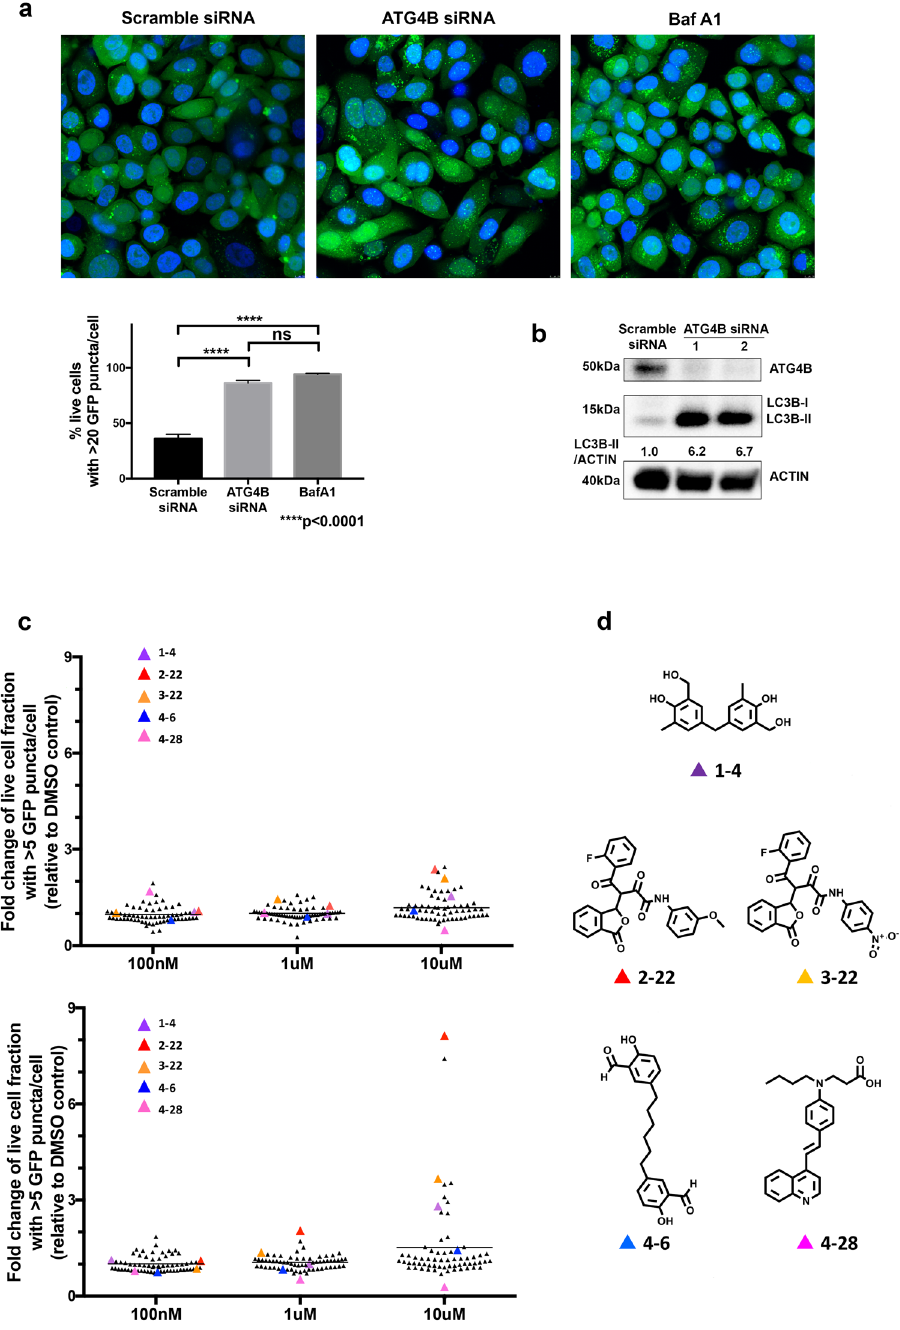
Figure 2. Screening of candidate ATG4B inhibitors. ( a ) Representative images of SKBR3-hrGFP-LC3B cells treated with control scramble-siRNA, ATG4B-siRNA, or bafilomycin A1 with quantitation of GFP-LC3B puncta shown in the bar graph below. Five randomly selected fields for each condition were analyzed in 2 independent experiments; error bars, SEM. ( b ) Representative western blot (n = 3) shows elevated LC3B-II levels in SKBR3 cells treated with ATG4B-siRNA compared to the control scramble-siRNA. Full-length blots are presented in Fig. S1. ( c ) Effect of small molecule compounds on the fraction of live cells with greater than five GFP-LC3B puncta in SKBR3 hrGFP-LC3 cells. Compounds were tested at three concentrations (100 nM, 1 μ M and 10 μ M) and two time-points, 6 h (top graph) and 24 h (bottom graph). The average values (normalized to DMSO vehicle control) from 3 independent experiments are shown. Colored triangles indicate 5 compounds that showed a statistically significant difference (p < 0.05) compared to vehicle control at one or more concentrations and timepoints and also inhibited ATG4B enzyme activity in a dose dependent manner (Table S1). Of these 5 compounds, only 2–22 and 3–22 showed a statistically significant difference at the 6 h time-point, while all 5 compounds showed a significant difference at one or more concentrations at the 24 h time-point. ( d ) Structure of 5 inhibitors of ATG4B. Compounds are named by screening codes and relate to NCI codes as depicted in Table S1. Titration curves are presented in Table